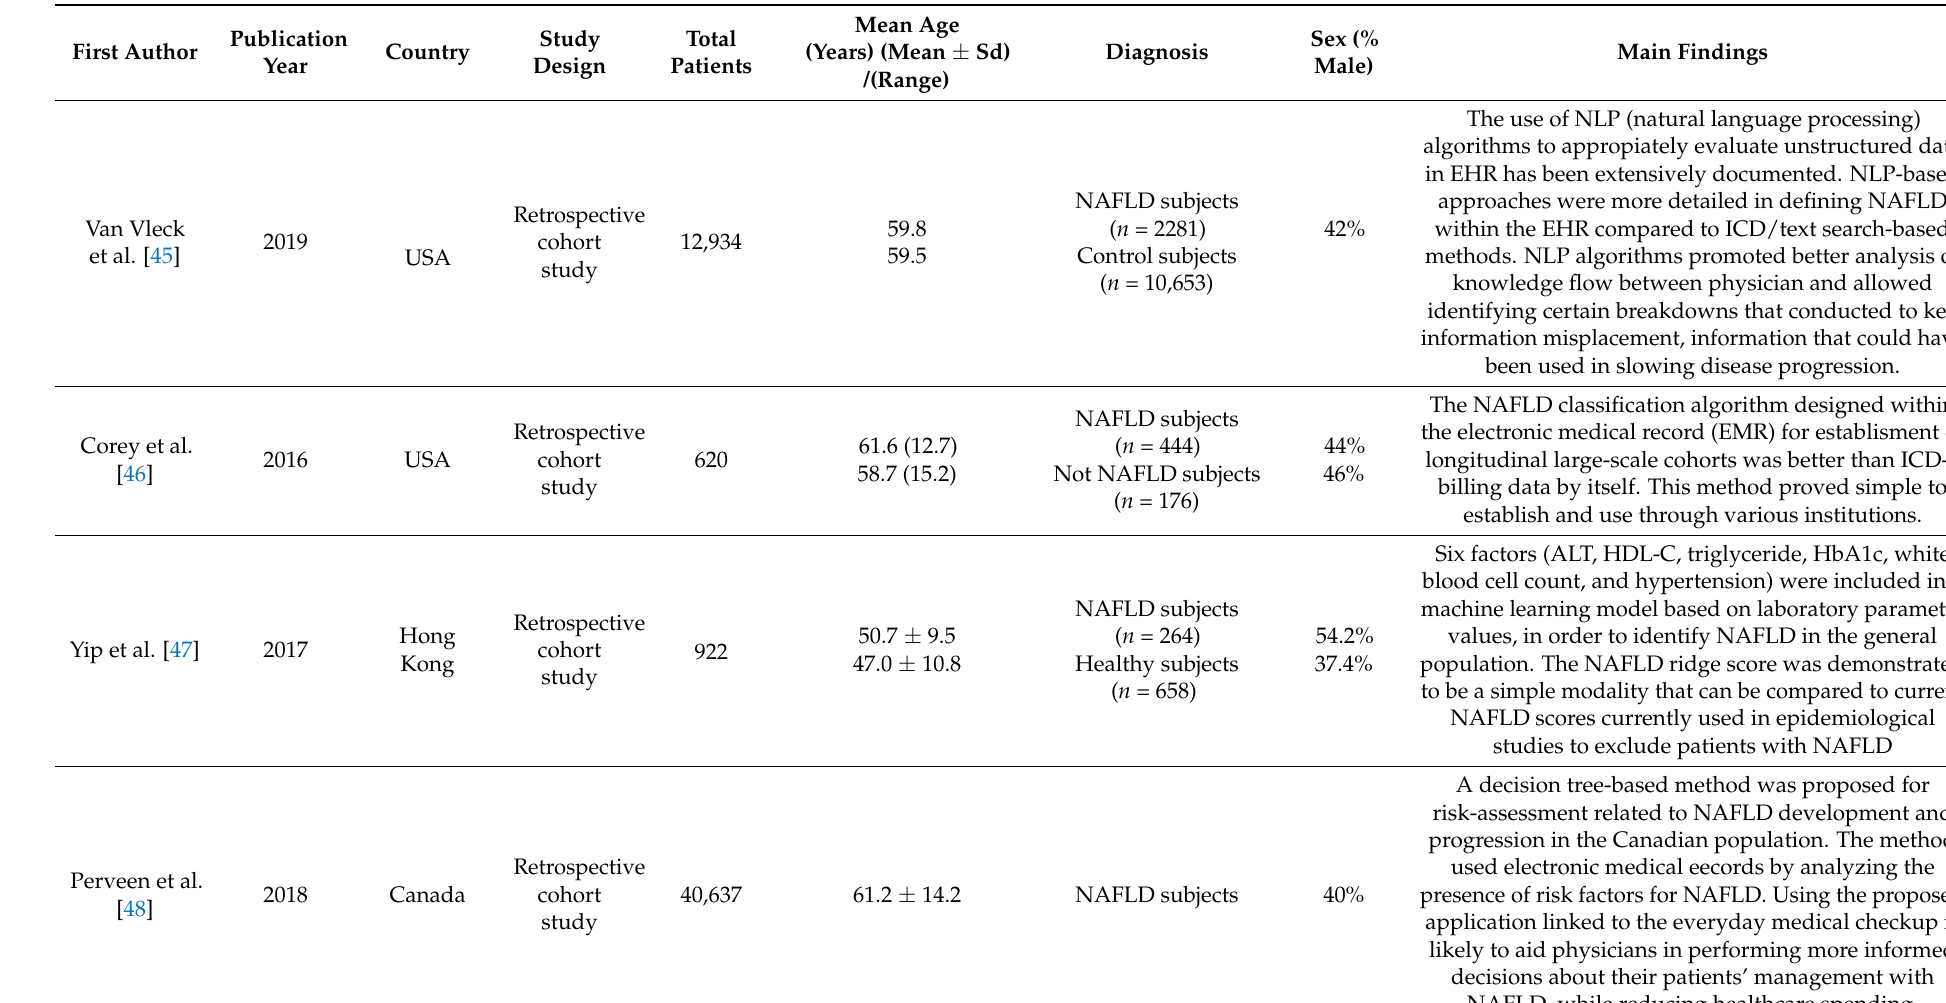
Table 5. Studies assessing artificial intelligence-based technologies on electronic health